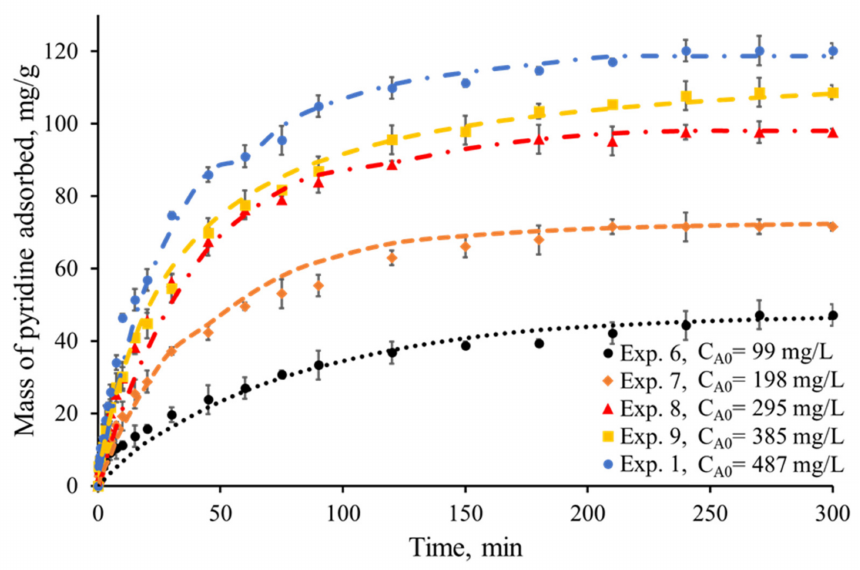
Figure 8. Variation in ACC adsorption capacity as a function of the mass of pyridine adsorbed. Predictions from the advection–diffusion model are represented by dashed lines, while the discrete values correspond to experimental